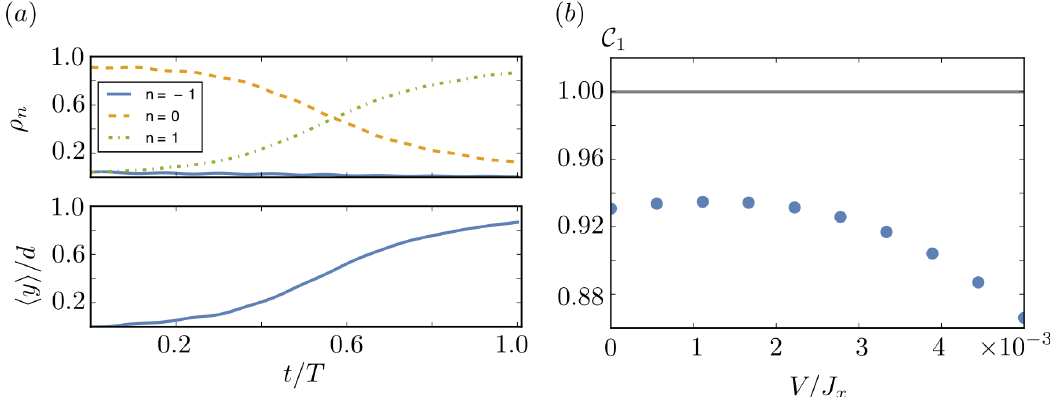
π = 3. and N y 3 . (b) Measured ground band Chern x